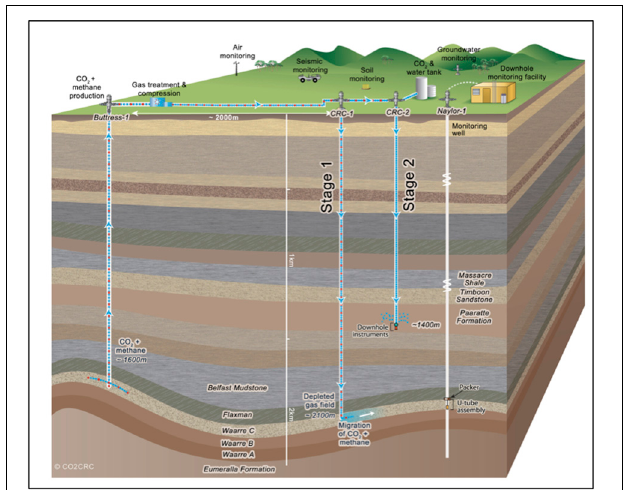
FIGURE 1 | Graphical representation of the CO2CRC Otway project site. The sandstone CO 2 storage aquifer is found within the Paaratte Formation, which is located approximately 1400m TVDSS at latitude: 38 ◦ 31 (cid:3) 44 (cid:3)(cid:3) and longitude 143 ◦ 48 (cid:3) 43 (cid:3)(cid:3) . Image source: